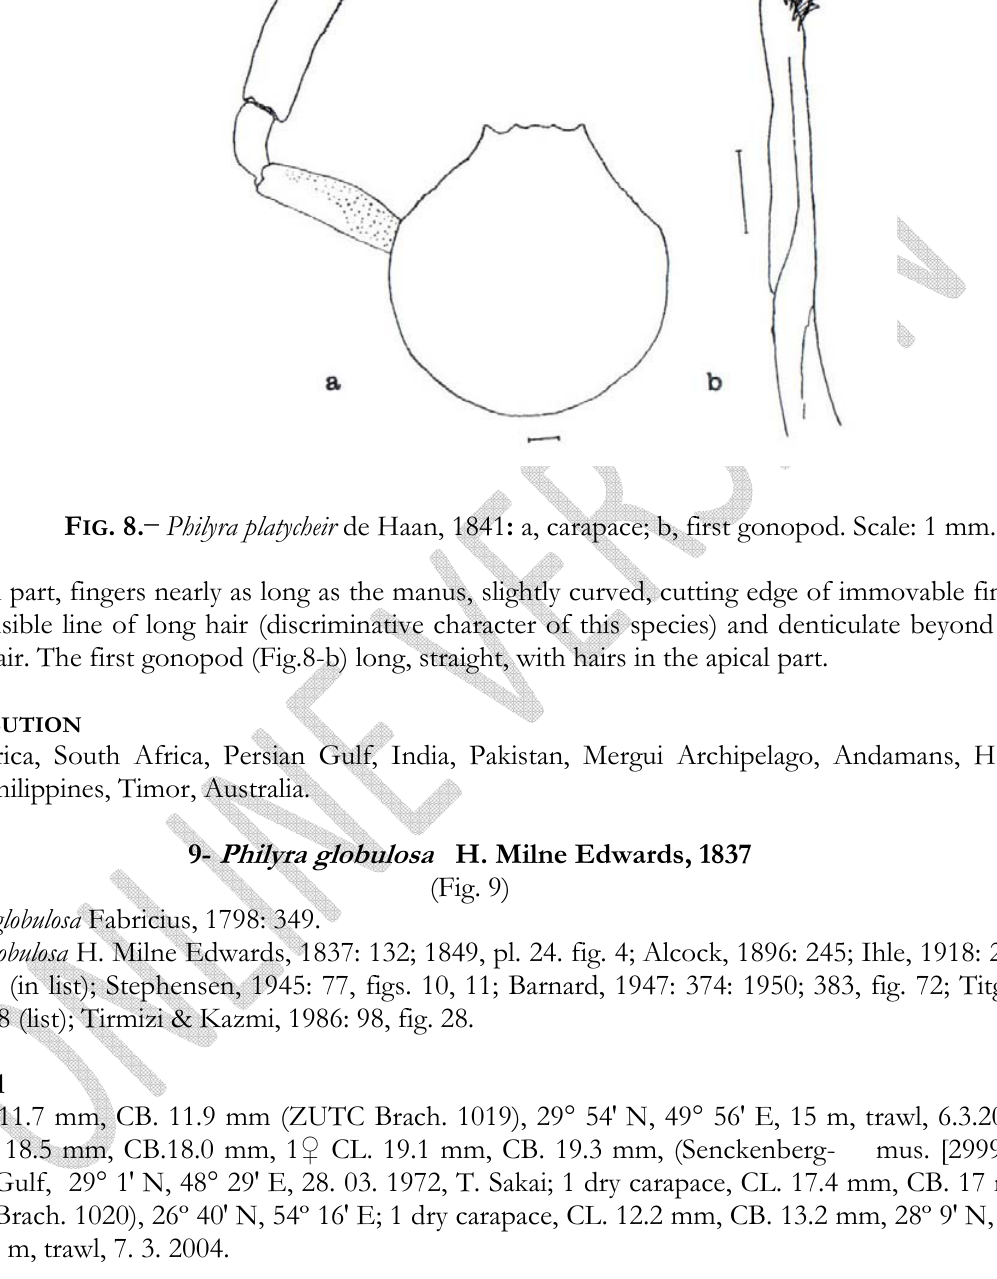
Carapace (Fig.9-a) circular, dorsal surface of carapace completely covered with small granules.